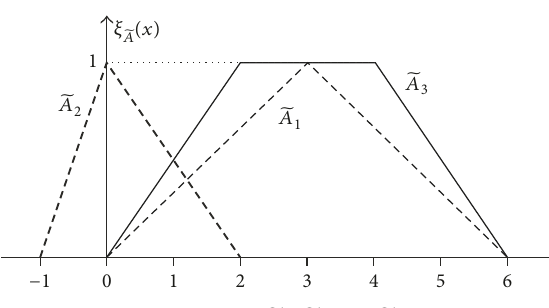
̃𝐴 ̃𝐴 ̃𝐴 1 , 2 , and 3 in Example 19. ̃𝐴 ̃𝐴 󸀠 2 ( 2 ) as the smallest (largest).